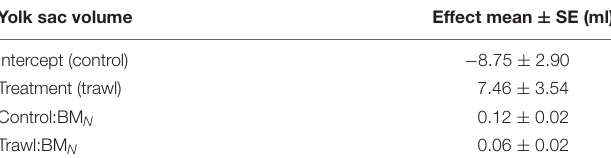
TABLE 1 | Effects obtained from the most parsimonious linear mixed effects model illustrating the influence of neonate body mass (BM N ) and maternal treatment group [Control ( n = 16) or Trawl ( n = 11)] on yolk sac volume at birth.